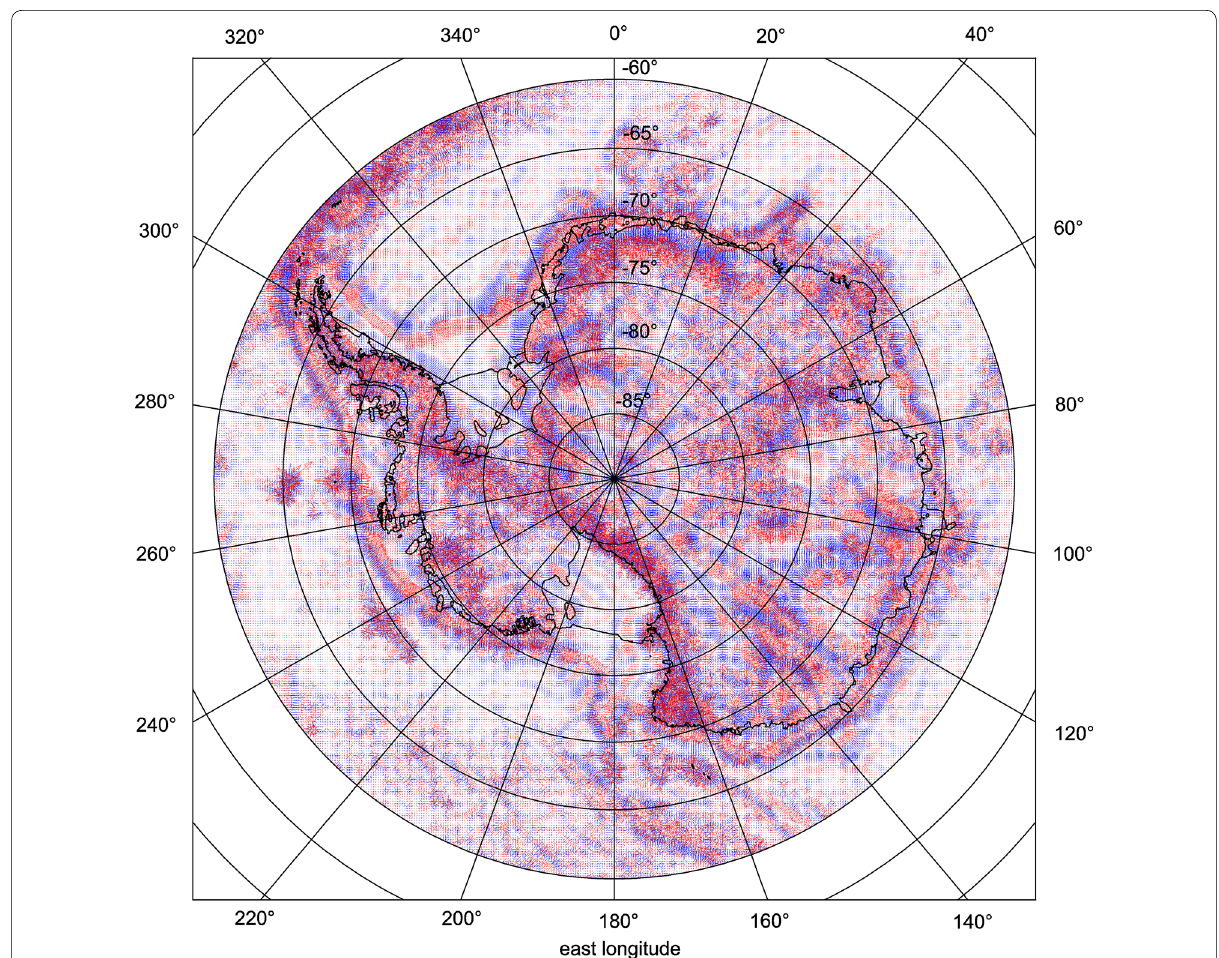
Fig. 2 The values of the virtual deformations vd (in blue for compression, in red for dilatation) for the whole Antarctica. The Wilkes Land anomaly is clearly visible as a semicircular feature with alternating compression and dilatation semirings, fragmented